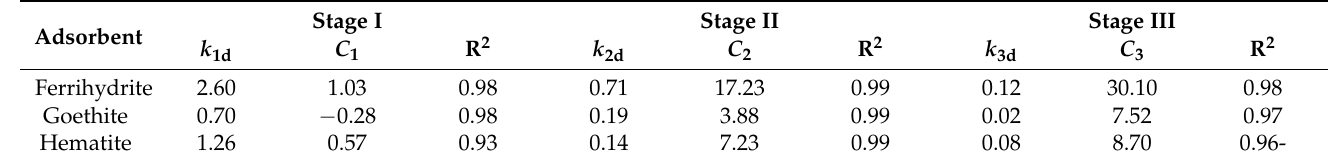
Table 3. Fitting results of intragranular diffusion models of iron